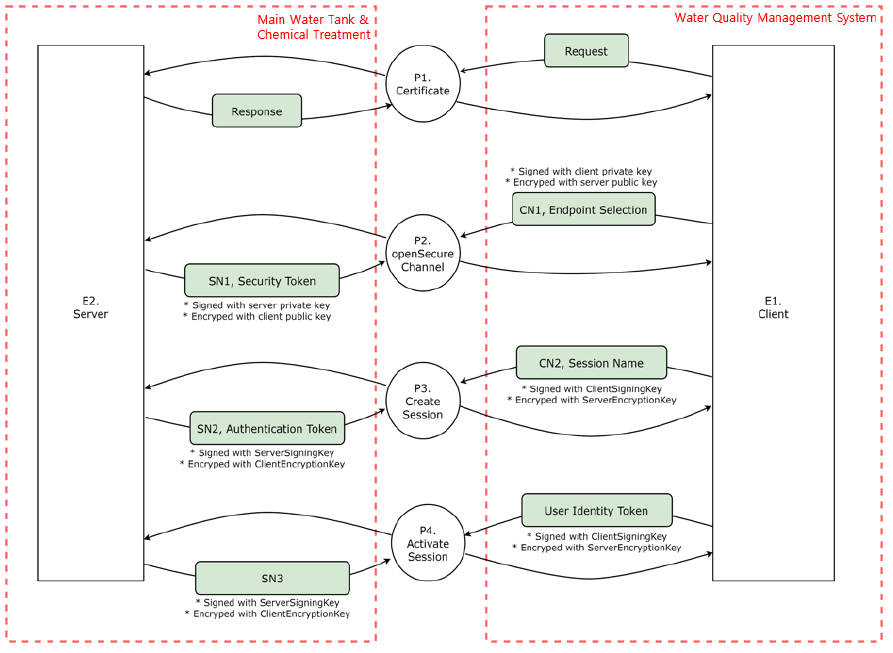
Figure 11. DFD of the OPC UA server–client system.